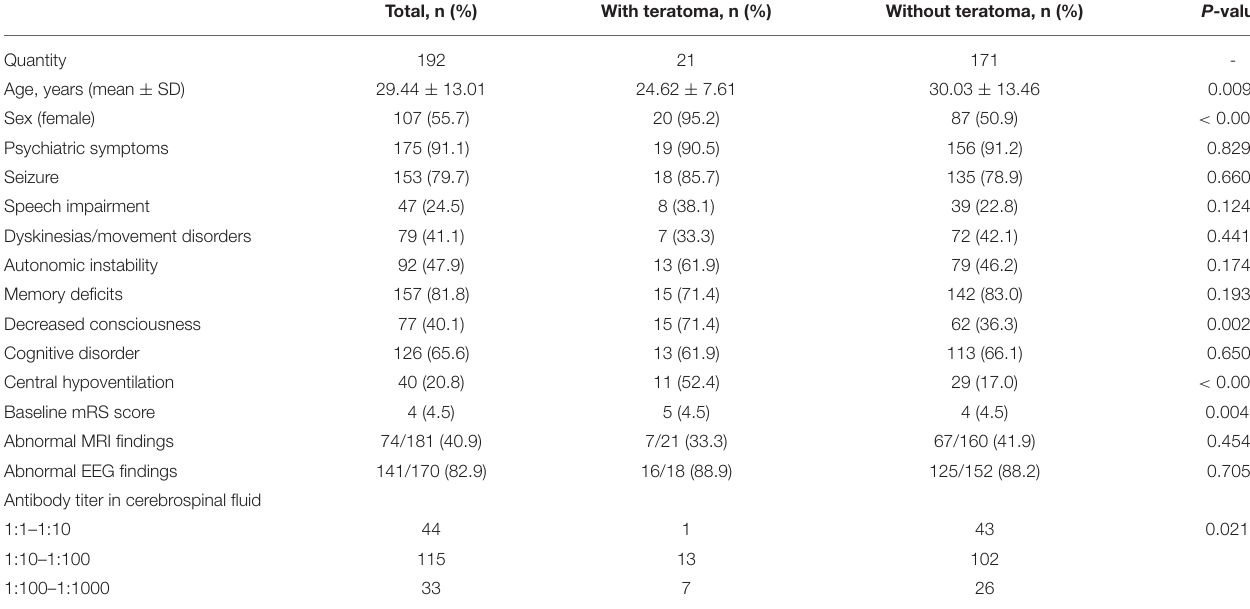
TABLE 1 | Clinical features of patients with and without teratoma. Total, n (%) With teratoma, n (%) Without teratoma, n (%) P -value